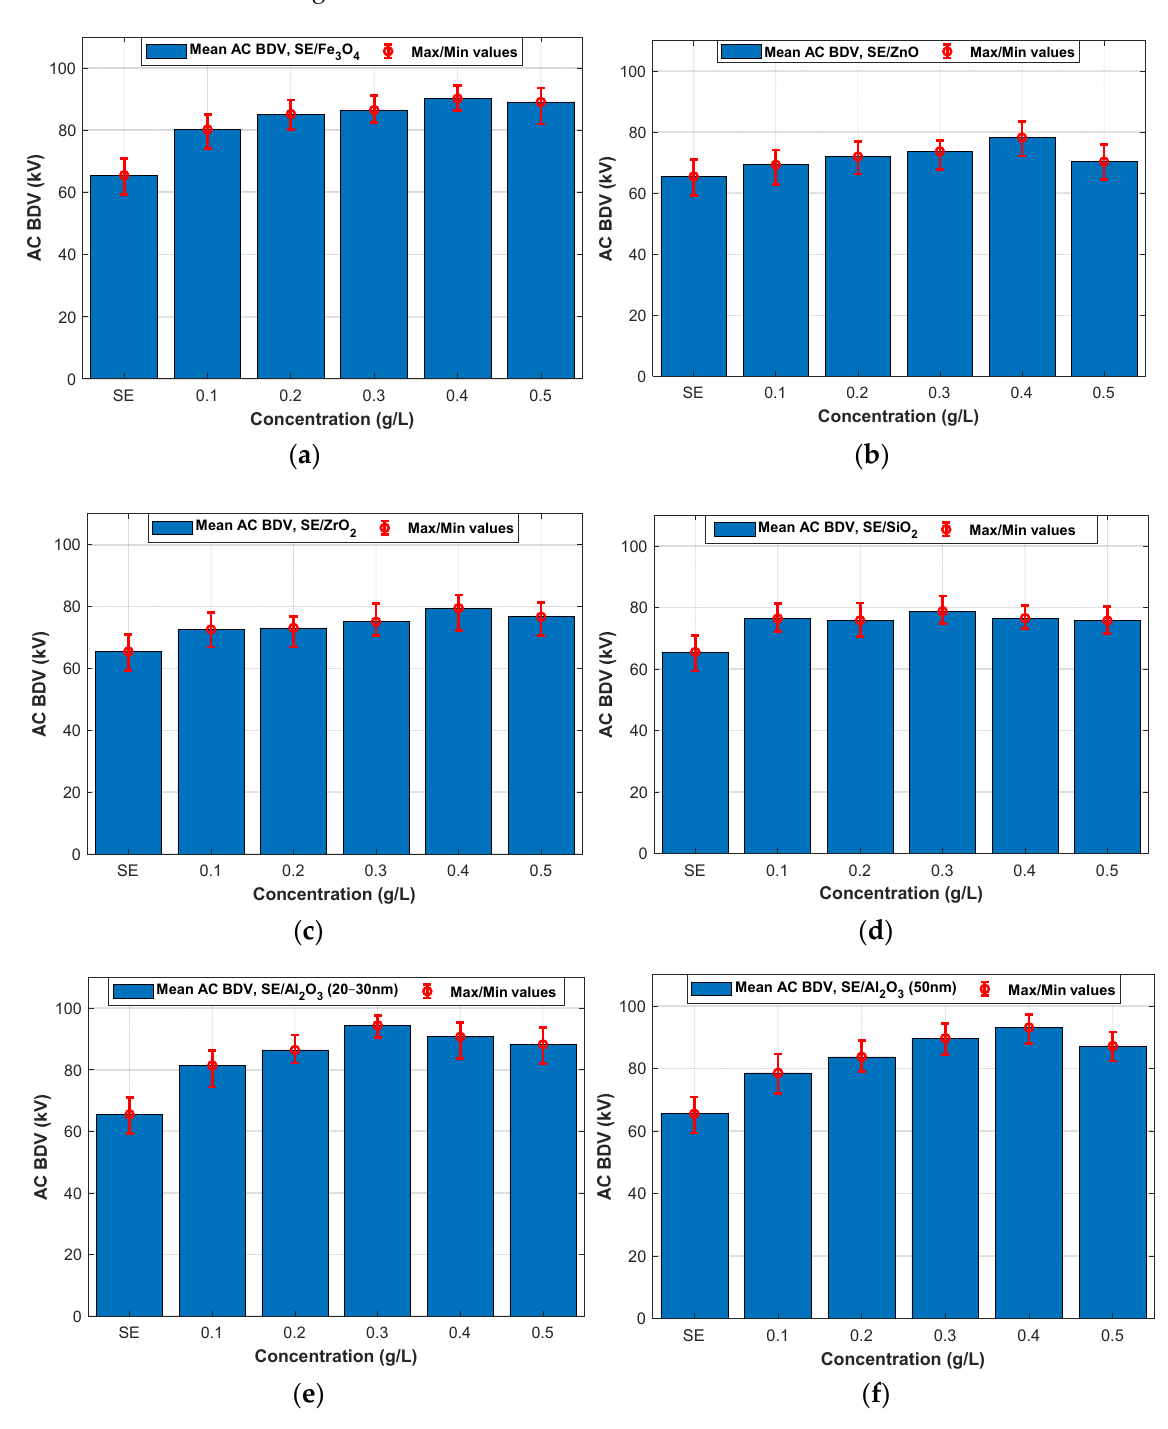
Figure 5. Mean breakdown voltages of synthetic ester and synthetic ester-based nanofluid at different concentrations of nanoparticles: ( a ) Fe 3 O 4 (20 nm), ( b ) ZnO (25 nm), ( c ) ZrO 2 (20–30 nm), ( d ) SiO 2 (10–20 nm), ( e ) Al 2 O 3 (20–30 nm), ( f ) Al 2 O 3 (50 nm).